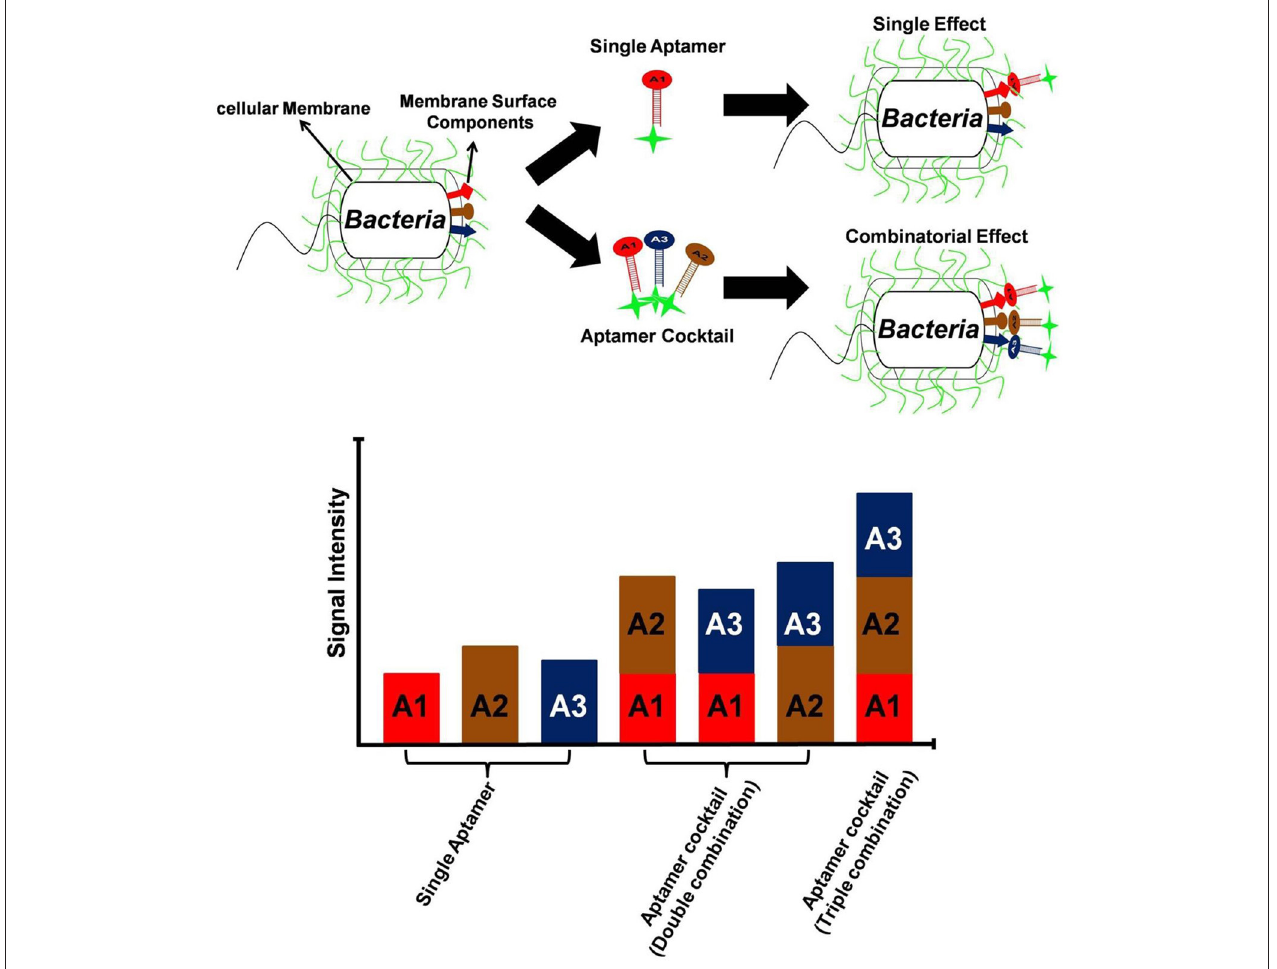
FIGURE 3 | Utility of aptamer cocktail in enhancing signal detection. Schematic concept of signal enhancement by aptamer cocktails for microbial cell detection and increase in fluorescence intensity of bacterial cell suspensions by the interaction with single aptamers or aptamer